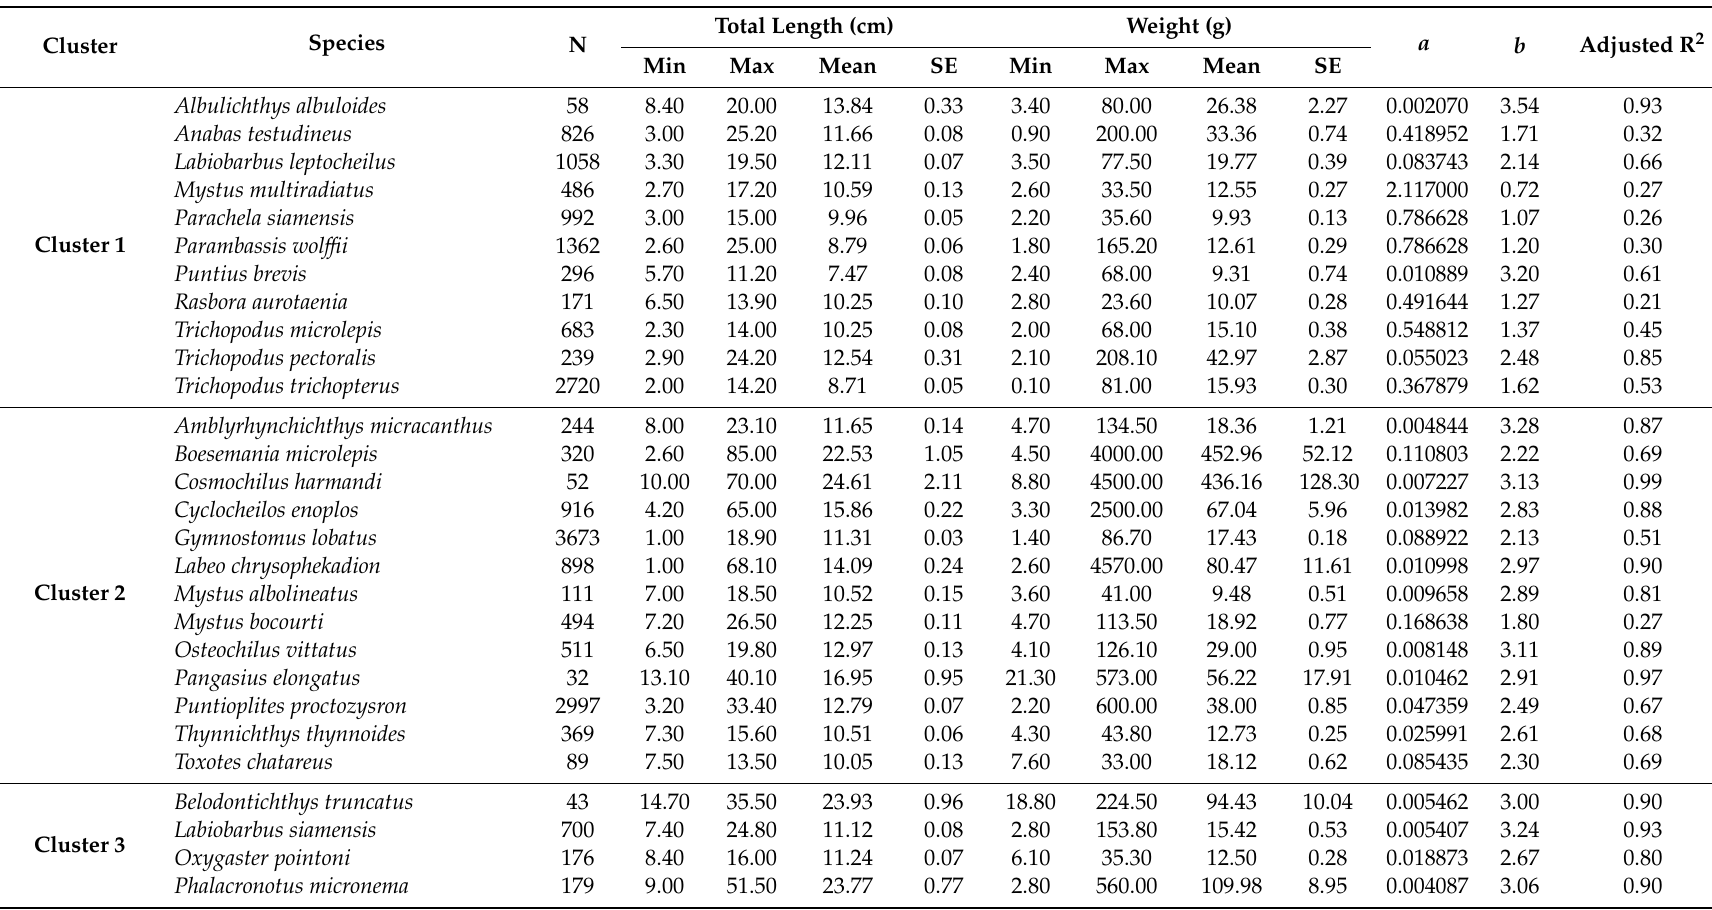
Table 1. Length–weight relationships of 45 indicator species by annual fish assemblage cluster. Parameter estimates of the linear models: a = intercept, b = slope [negative allometric growth ( b < 3), isometric growth ( b = 3), and positive allometric growth ( b > 3)]. N = number of observations. All slopes were significant at p < 0.001. Summary of slope b values by fish assemblage cluster is given in Figure